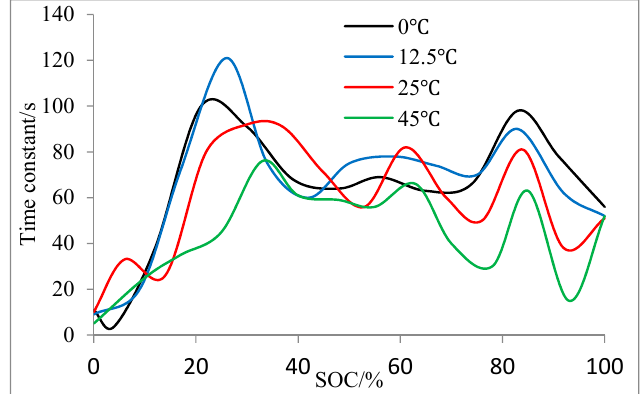
Figure 9. Time constant at different temperatures, SOCs.